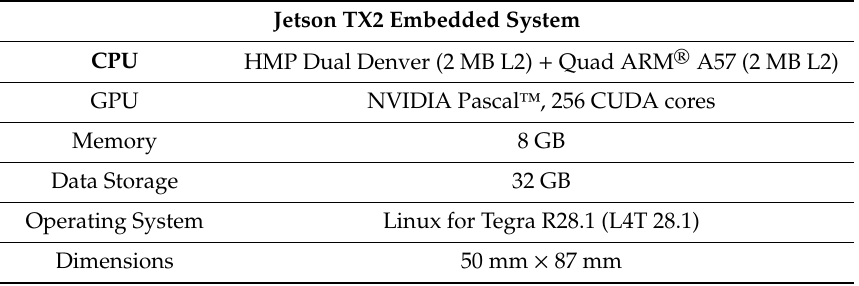
Figure 17. Jetson TX2 embedded system. Table 15. Specifications of the Jetson TX2 embedded system.